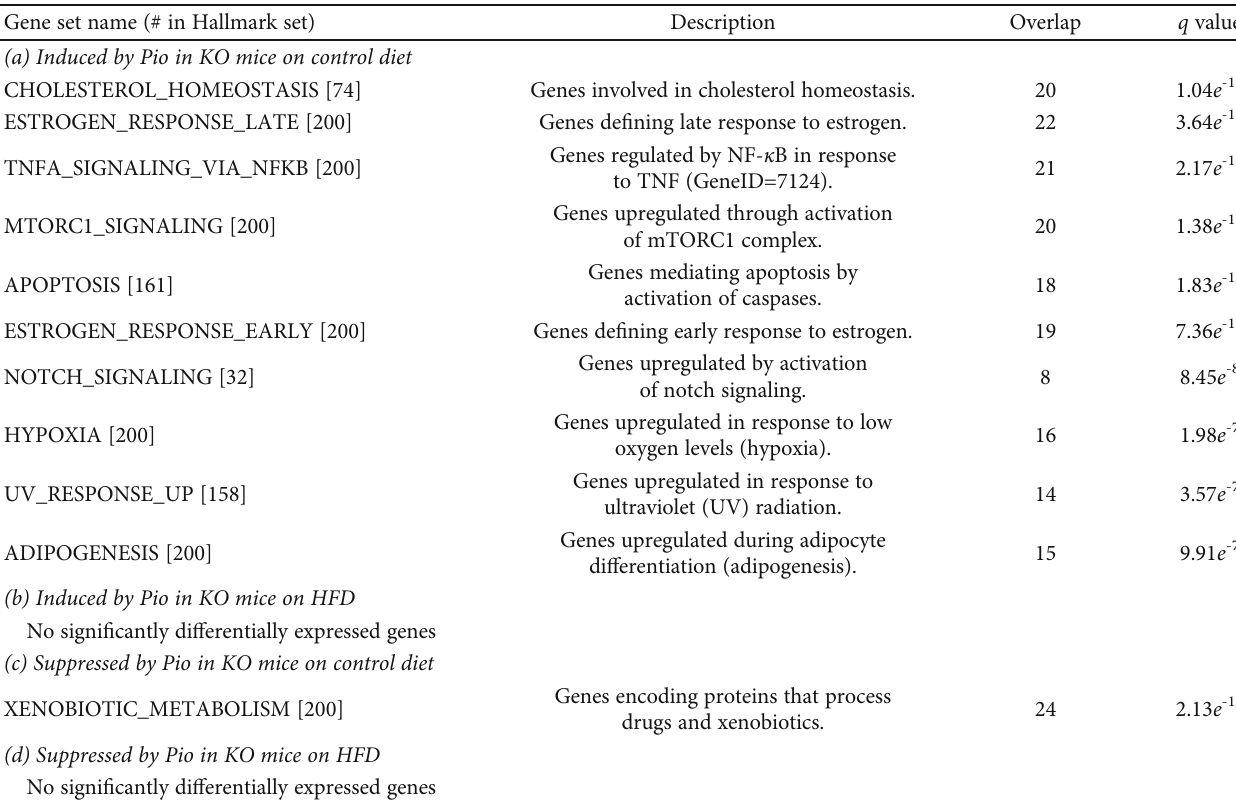
Table 2: Gene set analysis ∗ on RNA-Seq data from Pio-treated vs. Pio-untreated KO mice on control or HFD (as designated). Gene set name (# in Hallmark